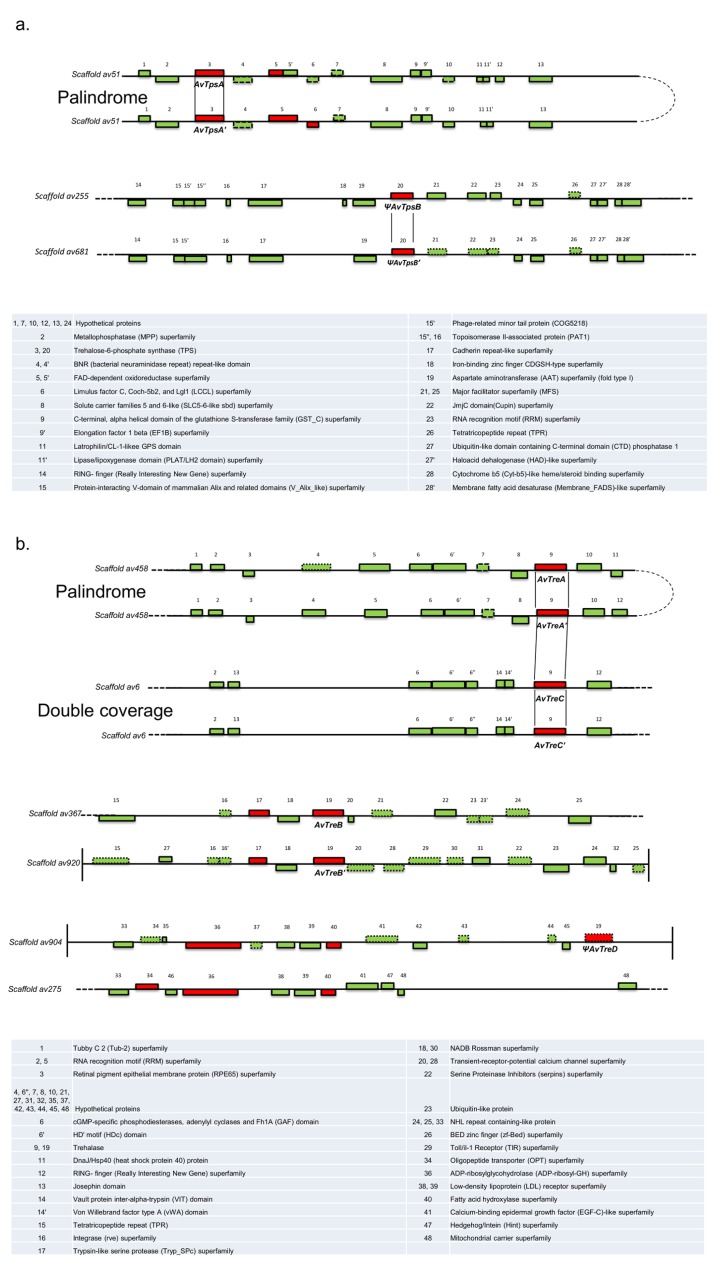
Annotation of the scaffolds containing (a) TPS and (b) TRE genes in Adineta vaga.Color-filled rectangles represent genes, numbers refer to the list at the bottom of the figure. Genes were colored in green or red if AI<45 or AI≥45, respectively. The genes annotated automatically in the A. vaga genome are surrounded with continuous lines, whereas discontinued lines surround additional genes detected during manual curation. The gene orientation is indicated by the position above (forward direction) or below (reverse direction) the line.